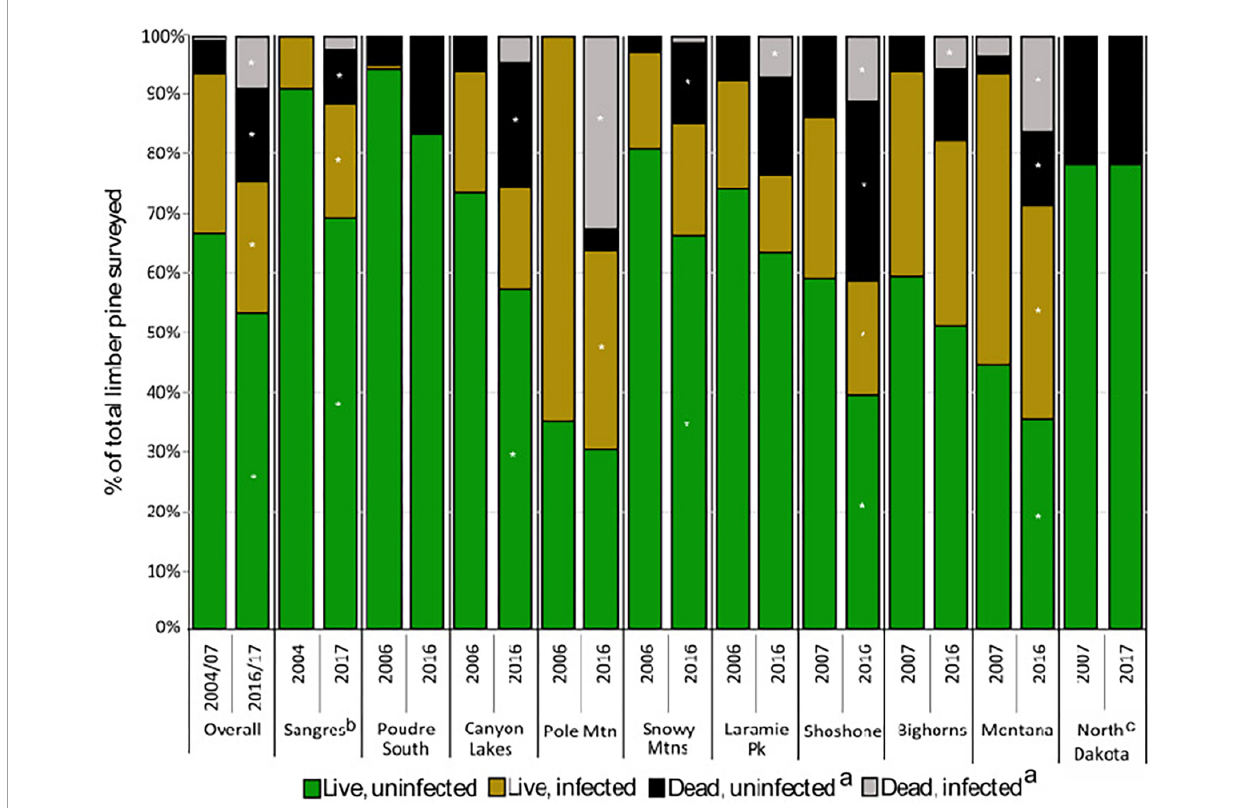
FIGURE4 Status of limber pine ( > 1.37 m tall) and white pine blister rust infection (2004–2007 to 2016–2017) (a) dead from any cause; (b) dead trees were not recorded in the Sangres in 2004–2007; (c) rust was not detected in ND. Asterisks represent significant change ( P < 0.05) using paired t -test from 2004–2007 to 2016–2017 within study